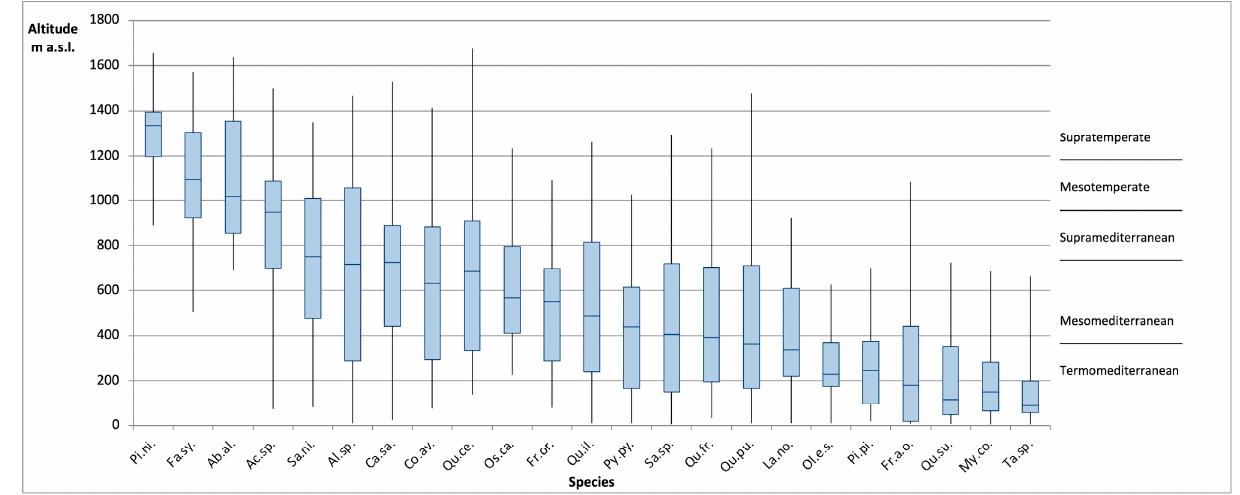
Figure 3. Altitude distribution of phytotoponyms related to principal species. The black horizontal line in each box plot indicates the median. The lower and upper edges of the box, respectively, indicate the 25% and 75% distribution percentiles. The line outside the box indicates the elevation of bioclimatic belts according to [66]. Pn = Pinus nigra subsp. laricio ; Fs = Fagus sylvatica L.; Aa = Abies alba Mill.; Ac = Acer sp. pl . ; Sn = Sambucus nigra L.; Al = Alnus sp. pl . ; Cs = Castanea sativa Mill.; Co = Corylus avellana L.; Qc = Quercus cerris L.; Oc = Ostrya carpinifolia Scop.; Fo = Fraxinus ornus L.; Qi = Quercus ilex L.; Pp = Pyrus pyraster (L.) Baumg; Sa = Salix sp. pl . ; Qf = Quercus frainetto Ten.; Qp = Quercus pubescens s.l. ; Ln = Laurus nobilis L.; Oeo = Olea europaea var. oleaster ; Fa = Fraxinus angustifolia subsp. oxycarpa ; Qs = Quercus suber L.; Mc = Myrtus communis L.; Ta = Tamarix sp.pl .